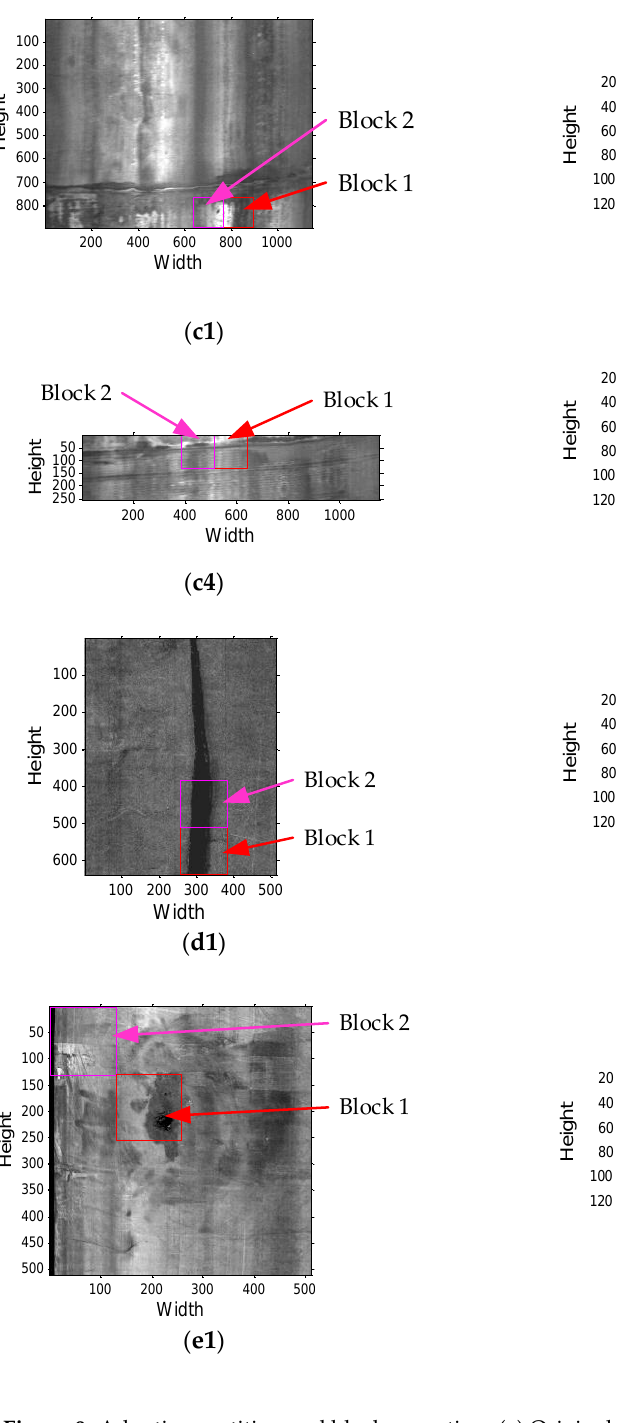
Figure 9. Adaptive partition and block operation. ( a ) Original image. ( a1 ) Conveyor belt joint image (Image 1). ( a2 ) Longitudinal tear image (Image 2). ( a3 ) Hole breakage image (Image 3). ( b ) Region of interest (ROI) partition results. ( b1 ) ROI of Image 1. ( b2 ) ROI of Image 2. ( b3 ) ROI of Image 3. ( c ) Adaptive partition and block operation for Image 1. ( c1 ) Extracted ROI image of Image 1. ( c2 ) Block 1 of Figure 9(c1). ( c3 ) Block 2 of Figure 9(c1). ( c4 ) Extracted ROI image of Image 1. ( c5 ) Block 1 of Figure 9(c4). ( c6 ) Block 2 of Figure 9(c4). ( d ) Adaptive partition and block operation for Image 2. ( d1 ) Extracted ROI image of Image 2. ( d2 ) Block 1 of Figure 9(d1). ( d3 ) Block 2 of Figure 9(d1). ( e ) Adaptive partition and block operation for Image 3. ( e1 ) Extracted ROI image of Image 3. ( e2 ) Block 1 of Figure 9(e1). ( e3 ) Block 2 of Figure 9(e1).